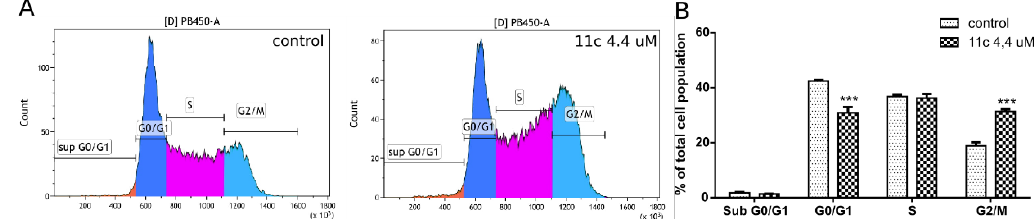
Figure 4. Effect of 11c on the cell cycle progression in HL- 60 cells. ( A ) : Representative flow cytometry results of the cell cycle changes. ( B ) : Percentage quantification of the total cell populations in each of the cell cycle phases expressed as mean ± SEM of a triplicate assay; *** p < 0.001.